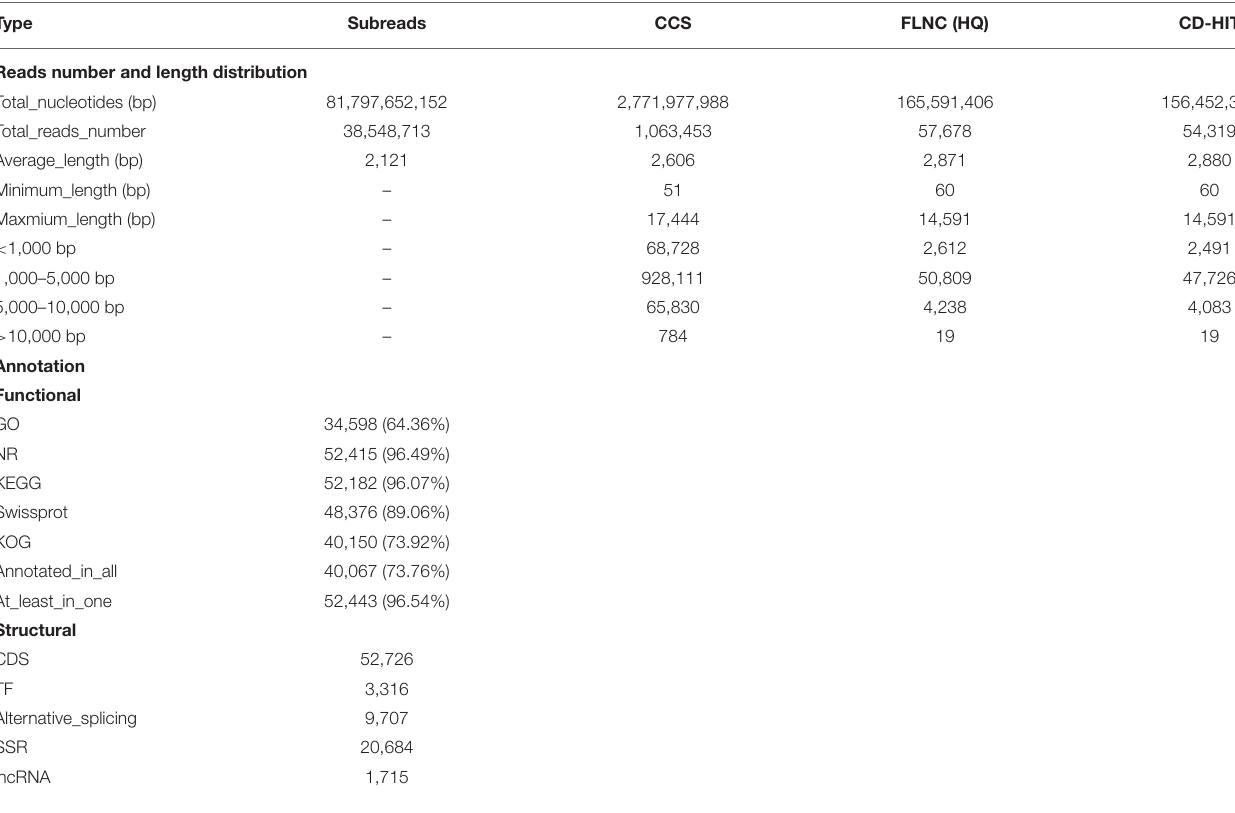
TABLE 1 | Reads and annotation statistics for the ISO-seq